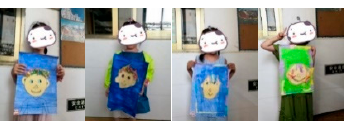
Figure A2. Children express their understanding of joy by drawing.